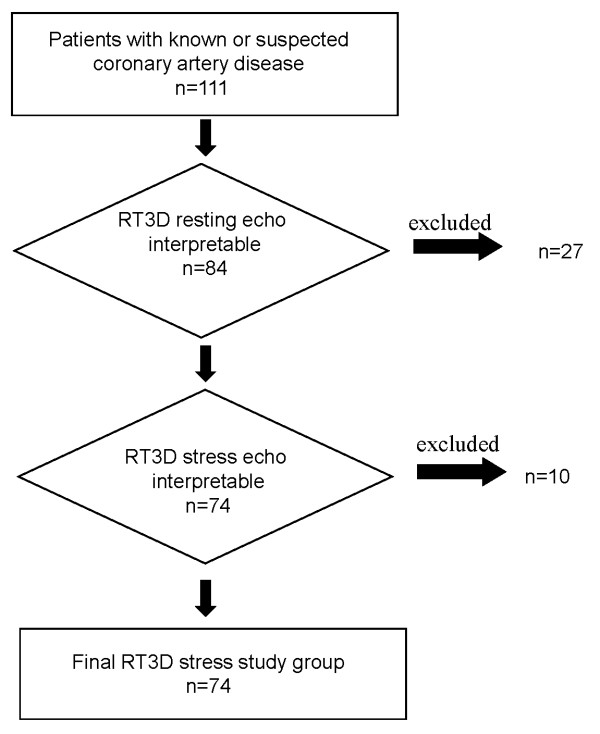
RT3D feasibility at rest: 27 patients were excluded from analysis because of translational artefact or for un-interpretable images. Ten patients were excluded for un-interpretable images at peak stress. Of 37 RT3D echo tests excluded from analysis, 25 were exercise and 12 pharmacological tests.